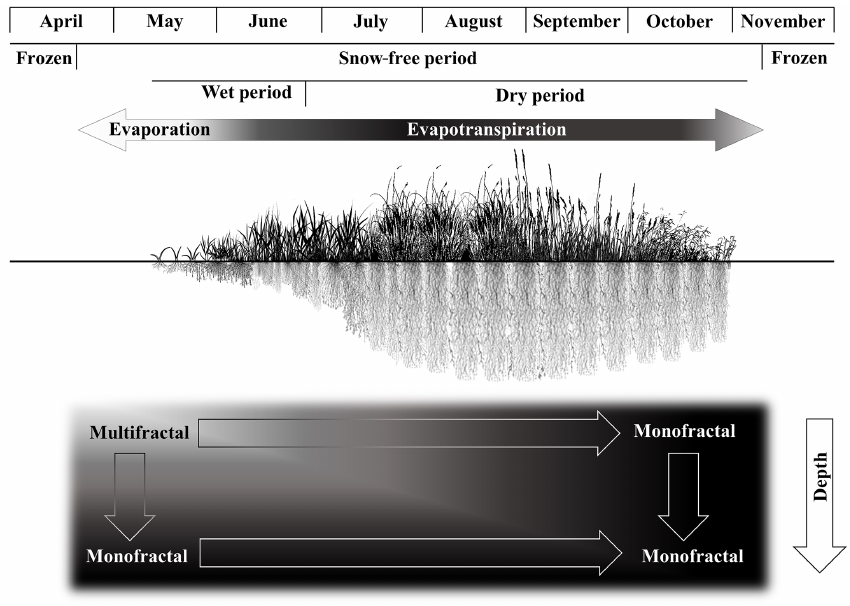
Figure 12. Conceptual schematics showing vegetation development over time, dominant water loss processes and the scaling behavior of soil water storage at different depths. The figure is developed based on field observations and scaling analysis. The scale of the figure is